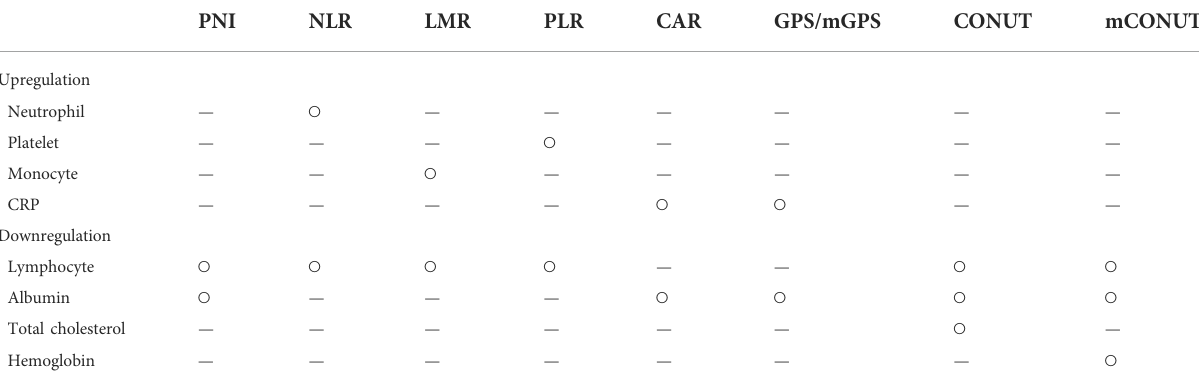
TABLE 3 Representative in fl ammation-related